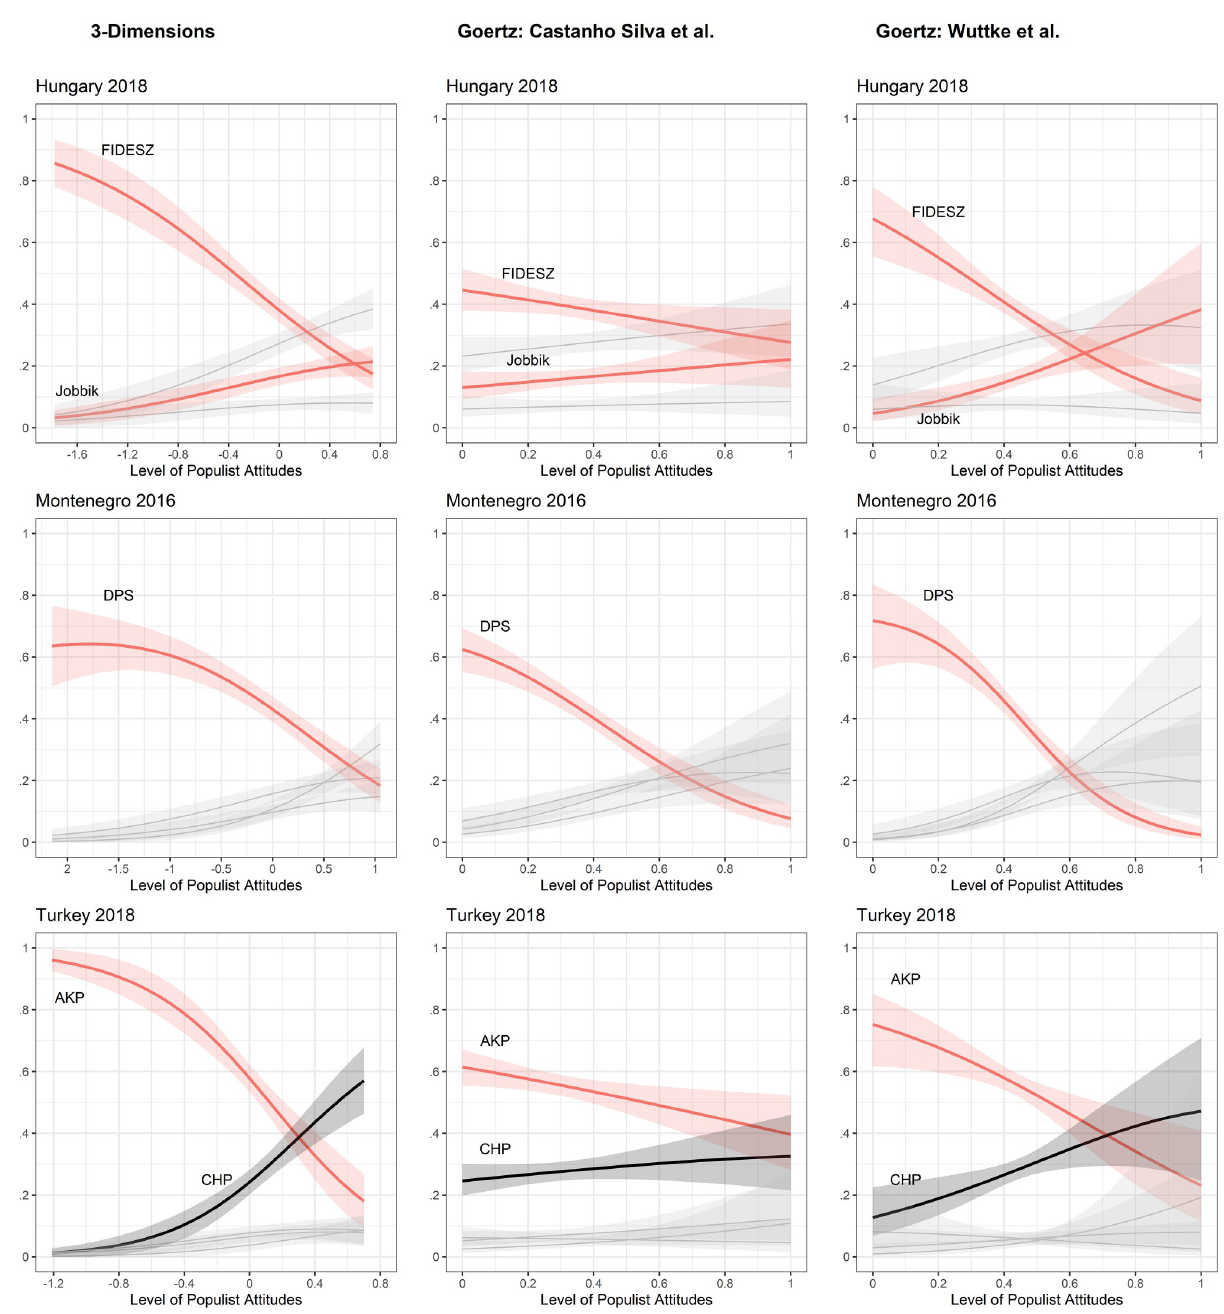
Fig 4. Predictions of populist vote across countries (robustness checks). Predictions of vote choice are based on multinomial structural equation models (3-Dimensions) and multinomial regression models (Goertz) with 95% confidence intervals.